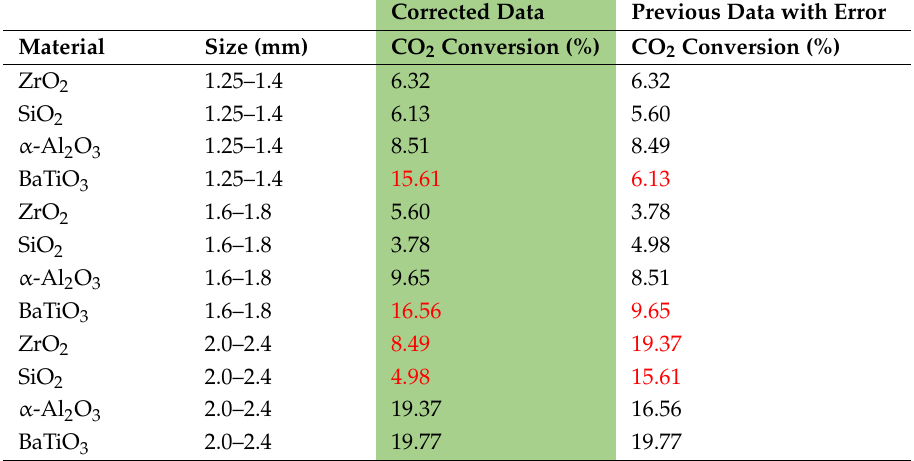
Table 1. The correct datapoints of CO 2 conversion in the CO 2 splitting reaction from [2] (green corrected data column) in relation to those that were mistakenly put (previous data with error) in Figure 1. Those that cause the largest di ff erences are marked in